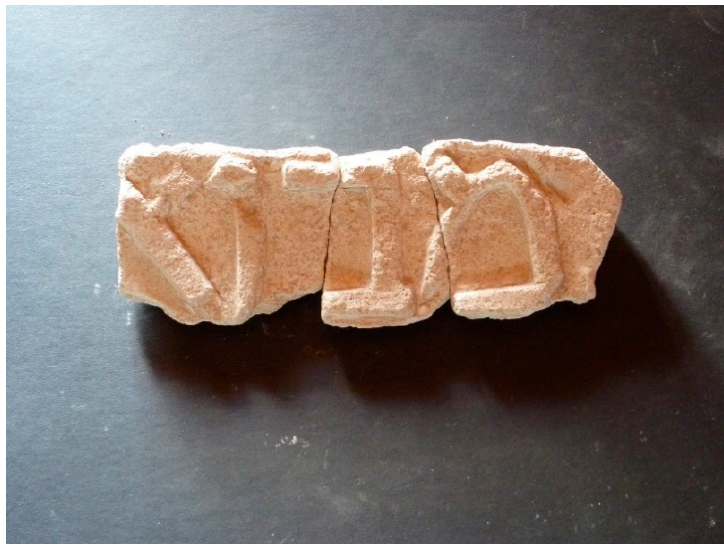
Figure 25. Fragment with Hebrew epigraphy, Molina de Aragón Synagogue. Author’s photo.